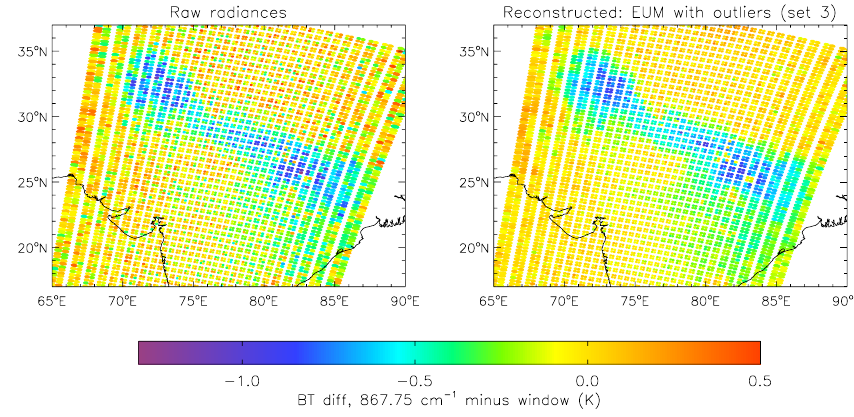
Fig. 3. Ammonia signal associated with agriculture over northern India. 13 May 2007, morning